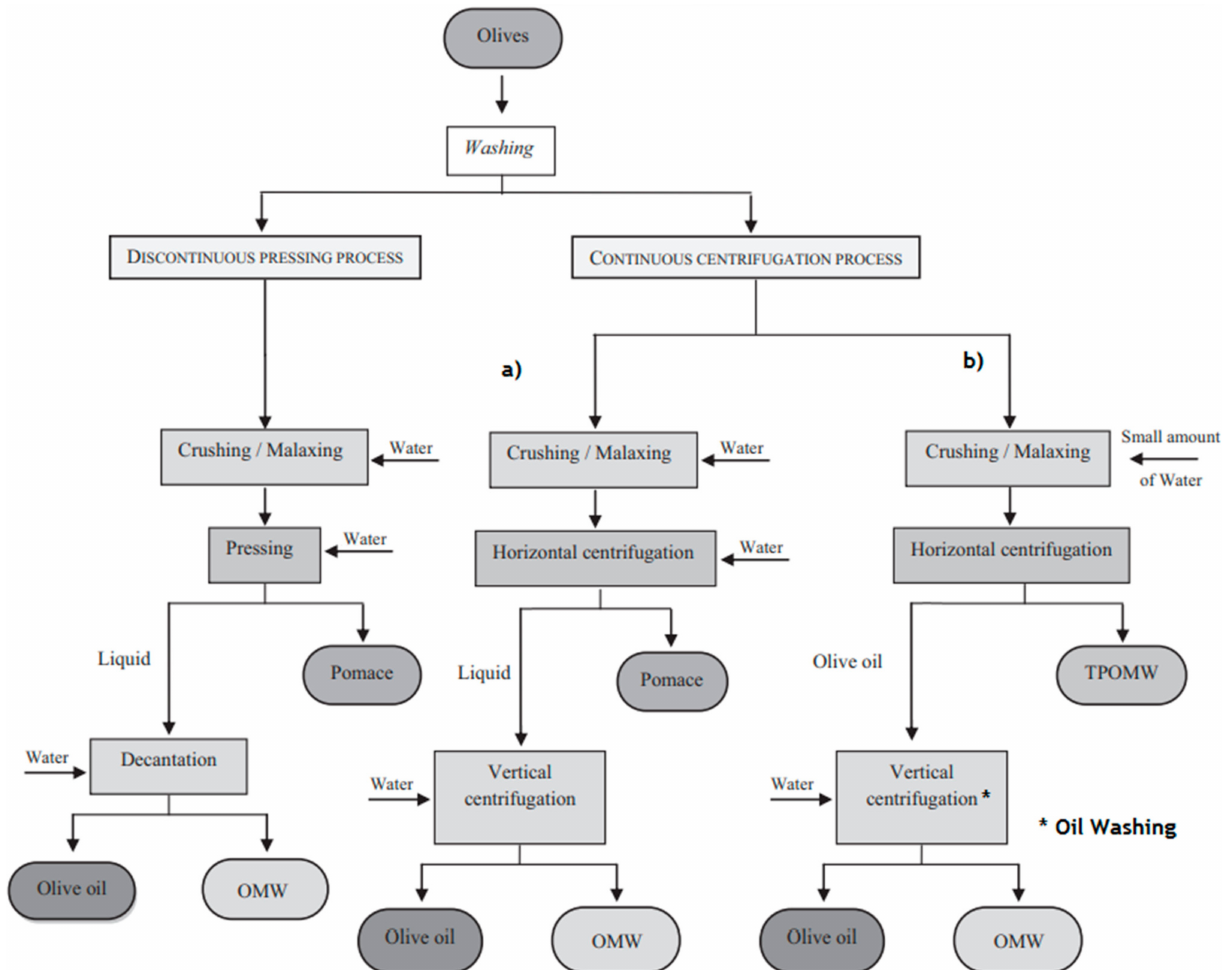
Figure 3. Main processes of olive oil production—traditional (pressing) method, (a) three-phase centrifugation method and (b) two-phase centrifugation method [7,8]. Reprinted with permission from Ref. [7]. Copyright 2021